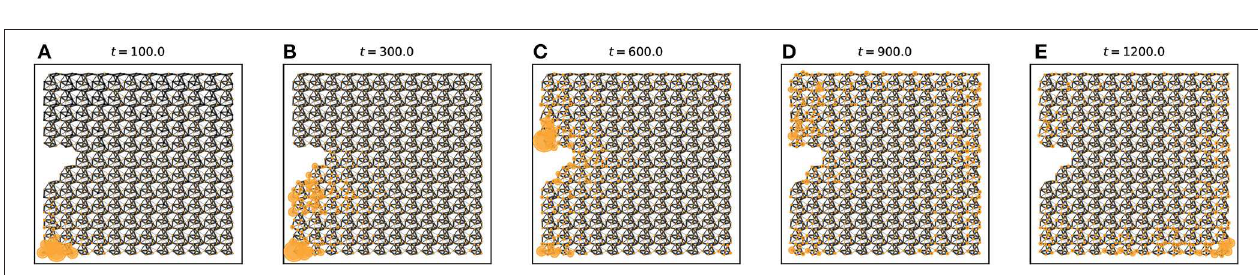
4 ) / ( 2 ) 2 where index n runs over all vertices ( n | u n | n | u n | = P P (cid:127) (cid:127) c , topologically protected localized | | = ω 2 gap , justifying our approximation. ≪